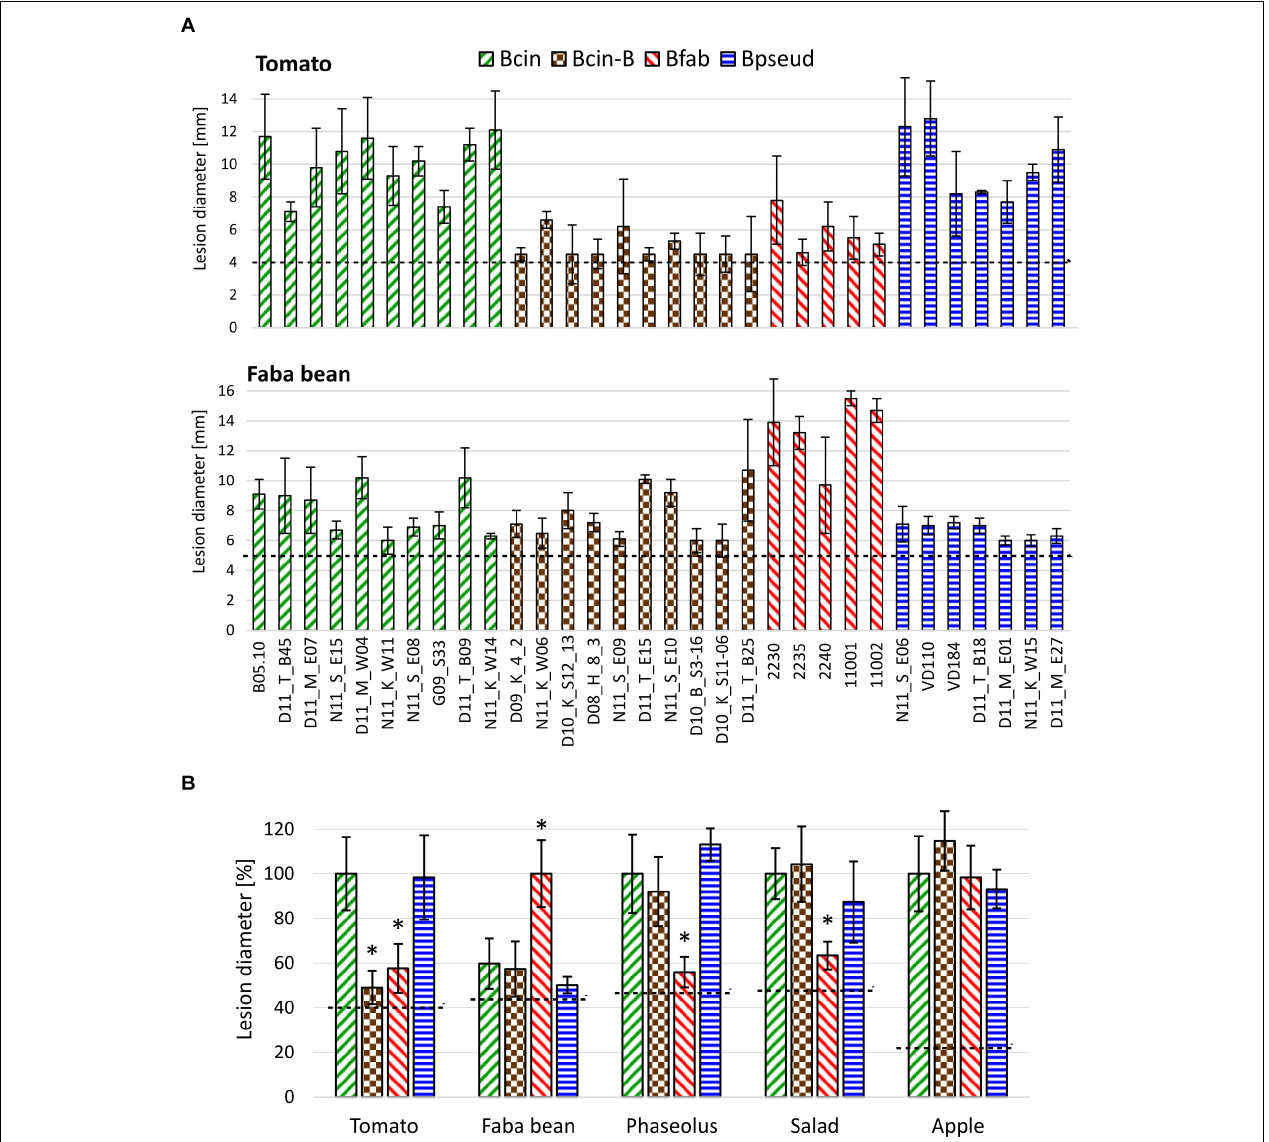
FIGURE 3 | Lesion formation by strains of B. cinerea , B. cinerea B, B. fabae, and B. pseudocinerea on tissues of different plants. (A) Lesions caused by individual isolates on tomato and faba bean leaves. (B) Mean lesion sizes of strains (shown in A and Supplementary Figure 3 ) from different Botrytis taxa on five different plant tissues, indicated in percent lesion size produced by B. cinerea (for faba bean: B. fabae ). The dotted lines indicate the average sizes of the inoculation droplets. The p -values by one-way ANOVA followed by Dunnett’s multiple comparisons post hoc test (control: B. cinerea ) are indicated. * p <